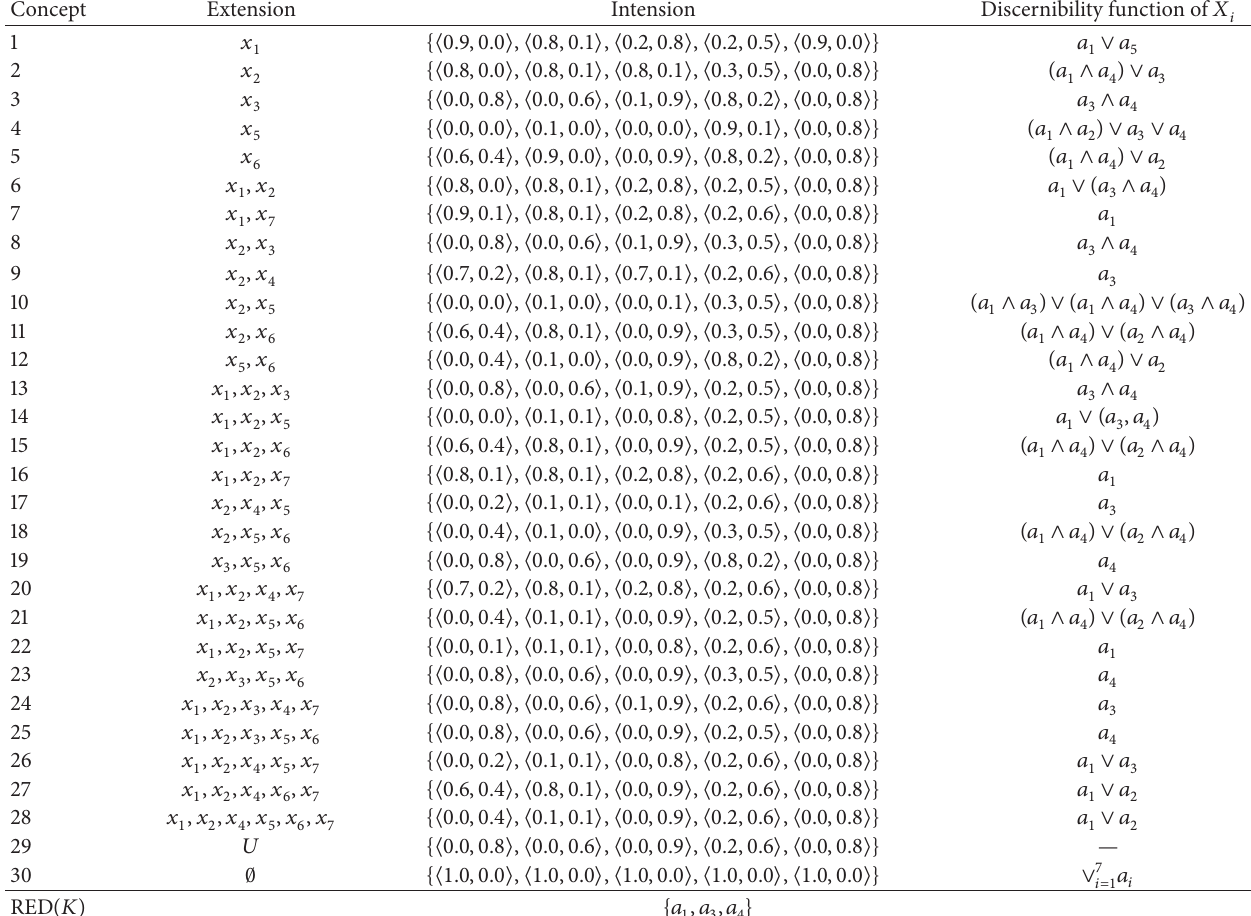
Table 4: The results of Example